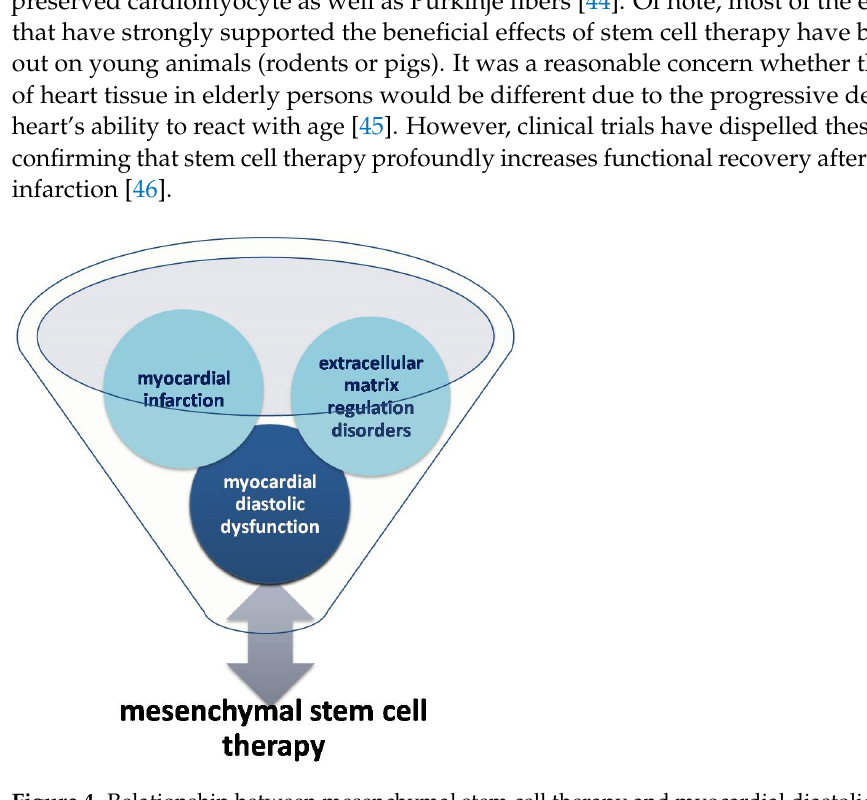
Figure 4. Relationship between mesenchymal stem cell therapy and myocardial diastolic dysfunc- tion (Central Illustration). (Central